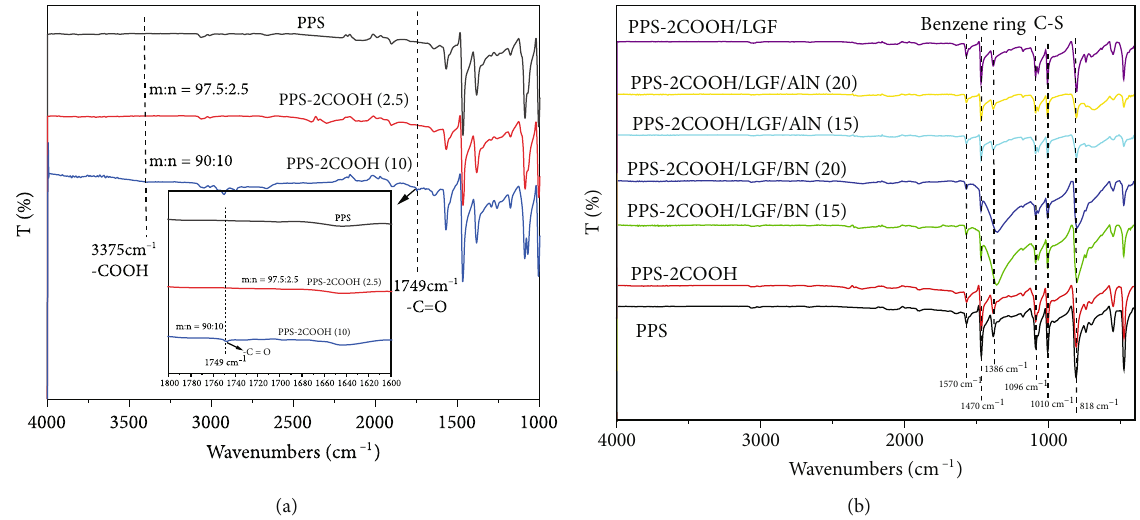
Figure 1: (a) FT-IR spectra of PPS and copolymer PPS-COOH at 4000-1000 cm -1 ; (b) FT-IR spectra of PPS, PPS-2COOH, PPS-2COOH/ LGF/BN, and PPS-2COOH/LGF/AlN at 4000-400cm -1